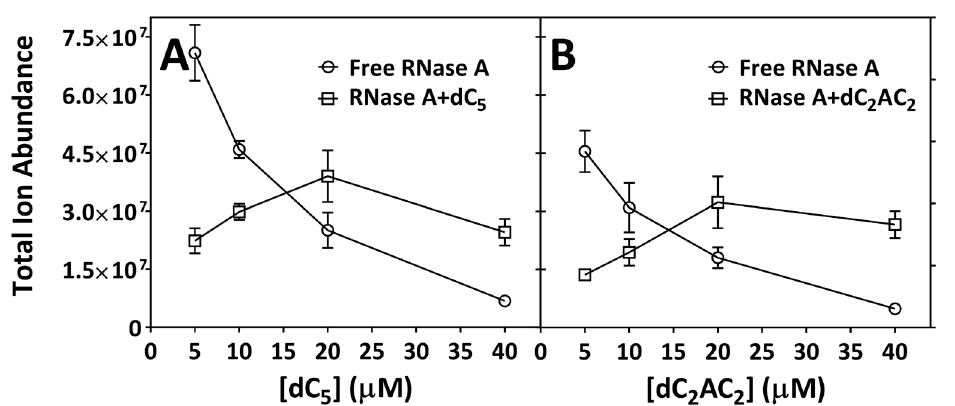
Figure 2. Total ion abundance for free RNase A and the ligand-bound forms vs. [deoxyoligonucleotide]. ( A ) [dC The data is from Table 5, where points represent the average (n=3) ± standard deviation.